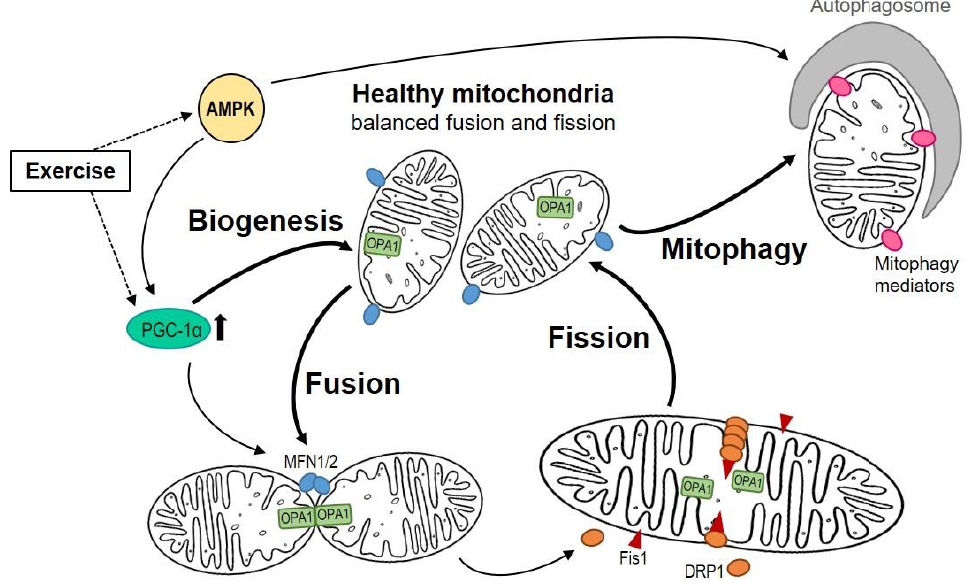
Figure 2. Relationships between mitochondrial biogenesis, fusion, fission and degradation in healthy mitochondria. Muscle mitochondria underlie extensive turnover and remodeling in re- sponse to a diverse panel of physiological inputs. Among the many activators of PGC1 α , AMPK seems to be the most crucial for regulating mitochondrial metabolism and biogenesis. PGC1 α acti- vates mitochondrial biogenesis and regulates mitochondrial dynamics by controlling the expression of MFN1, MNF2 and DRP1. Mitochondrial fusion is mediated by MFN1/2 for the fusion of the outer membrane and OPA1 for the inner membranes. Mitochondrial fission is controlled by DRP1 and Fis1. DRP1 is predominantly located in the cytosol and is targeted to the surface of mitochondria, where it binds to Fis1. This complex acts as a potential scission site for fission. Damaged or dysfunc- tional mitochondria are eliminated by mitophagy facilitated by different mediators. AMPK: AMP — activated kinase, DRP1: dynamin-related protein 1, ETC: electron transport chain, Fis1: fission pro- tein 1, MFN1/2: mitofusin1/2, OPA1: optic atrophy 1, PGC1 α : peroxisome proliferator — activated receptor gamma coactivator alpha. 4. Assessment of Mitochondrial Function As mitochondrial integrity is crucial for cellular bioenergetics and mitochondrial dysfunction has been shown to participate in a great spectrum of disease entities, various approaches have been taken in the detection and monitoring of mitochondrial function. Thus, it can be roughly divided into in vitro and in vivo diagnostic methods, targeting different functional units within the mitochondria [30]. In an attempt to link current prac- tical trends in modern intensive care medicine and recent advances in the assessment of mitochondrial function at the molecular and metabolic levels, we would like to discuss three promising in vivo diagnostic approaches for mitochondrial function. Magnetic resonance spectroscopy (MRS) is a specialized technique of common MR- imaging, which quantifies electromagnetic signals emitted by atoms or molecules within a certain region of interest [31]. With MRS, metabolic processes can be assessed in vivo using certain tracers, depending on the chemical composition of participating reactants. In regard to mitochondrial metabolism, 13 C-MRS can be used to determine utilization of carbohydrates and lipids via the TCA cycle and 31 P-MRS for evaluation of mitochondrial ATP metabolism via the assessment of phosphocreatine turnover [31]. MRS has also been used to evaluate ATP metabolism in primary motor neuron disease [32] and animal mod- els of sepsis [33], revealing impaired mitochondrial bioenergetics. However, according to expert opinion, MRS can only reliably quantify ATP turnover in exercising muscles, but